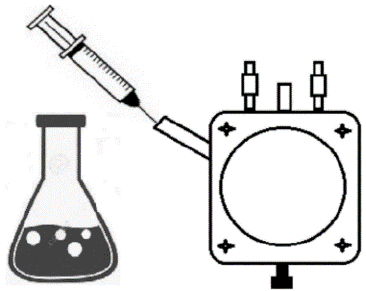
Figure 8. Schematic diagram of a commonly used impedance measurement Liquid Test fixture.